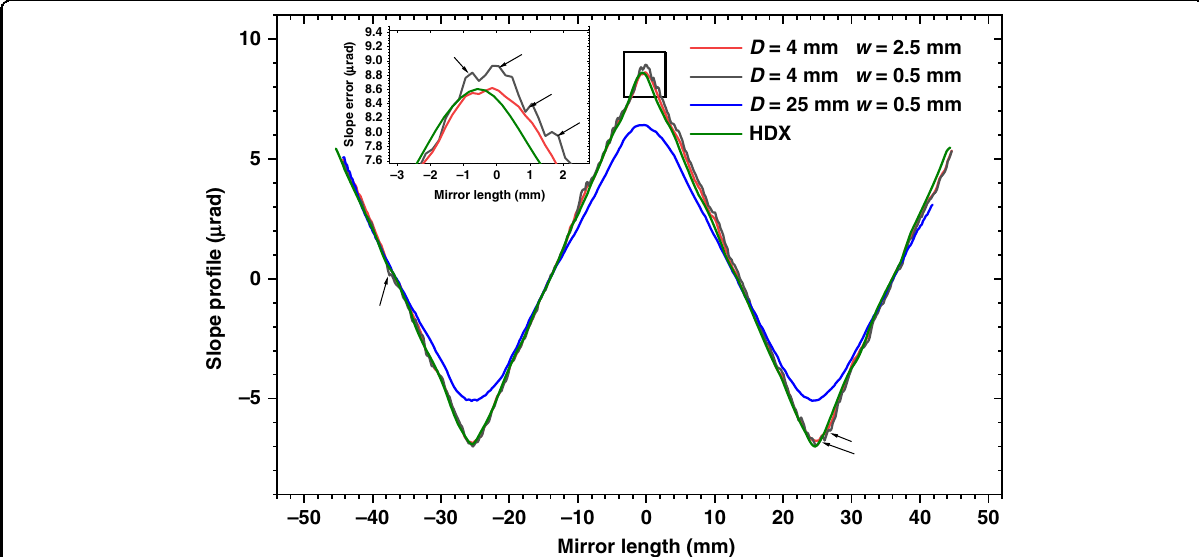
Fig. 5 The measured tangential mirror slope pro fi le of the elliptical mirror with SAM and HDX Fizeau interferometer. Each SAM dataset is labelled by its iris aperture D and subset window width w to demonstrate their effects on the spatial resolution. All SAM measurements use the same subset window length ( l = 0.5